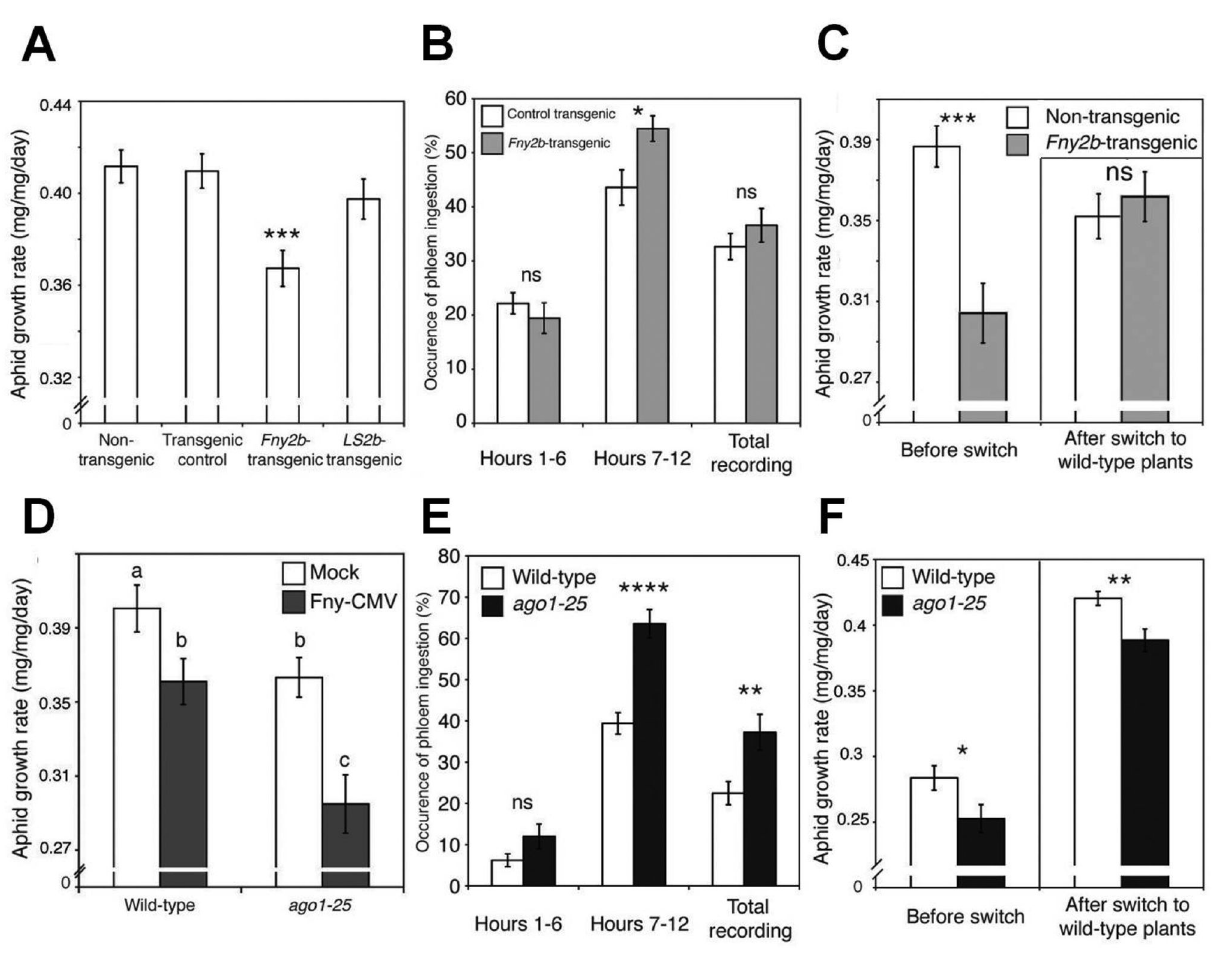
Figure 7. Disruption of AGO1 function by Fny2b induced antibiosis but not feeding deterrence to aphids. (A, D) Growth rate of individual aphids feeding on transgenic plants expressing the Fny2b or LS2b proteins and ago1-25 mutant plants, which are compromised in AGO1 activity, a major molecular target of Fny2b, n≥24. (B, E) Electrical penetration graph analysis of the amount of phloem feeding in Fny2b -transgenic plants and ago1-25 mutants over a 12-hour recording period, broken down into hours 1-6, 7-12, and over the entire period (C, F) Results of host-switching experiments where aphids were moved from their initial hosts (“before switch”) to uninfected, wild-type plants (“after switch”) to see if aphids could recover from any effects of the initial host on aphid growth rate, n≥24. Results of Student’s t -tests are indicated by asterisks: *, P <0.05; **, P <0.01; ***, P <0.001. Error bars represent standard error of the